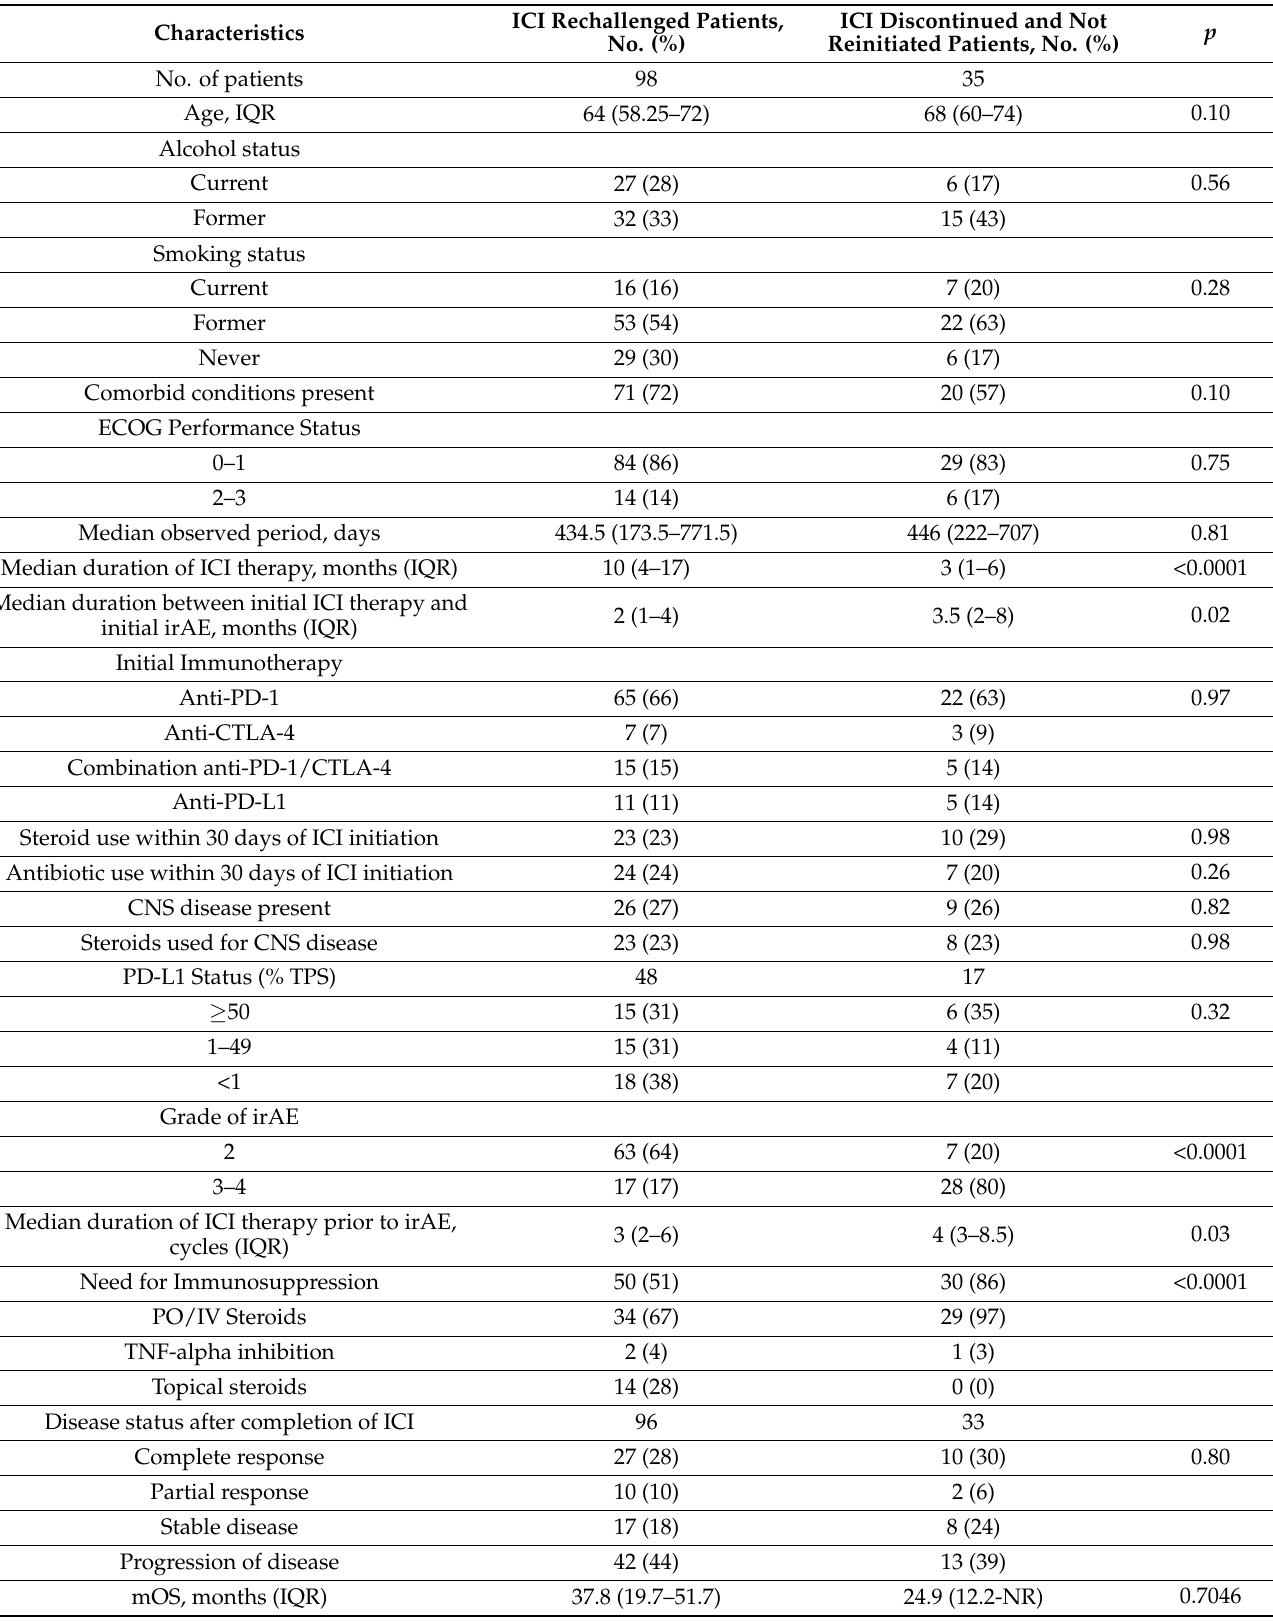
Table 3. “Rechallenged (Interrupted and Reinitiated + Not interrupted and Reinitiated after irAE)” compared to “Discontin- ued and Not